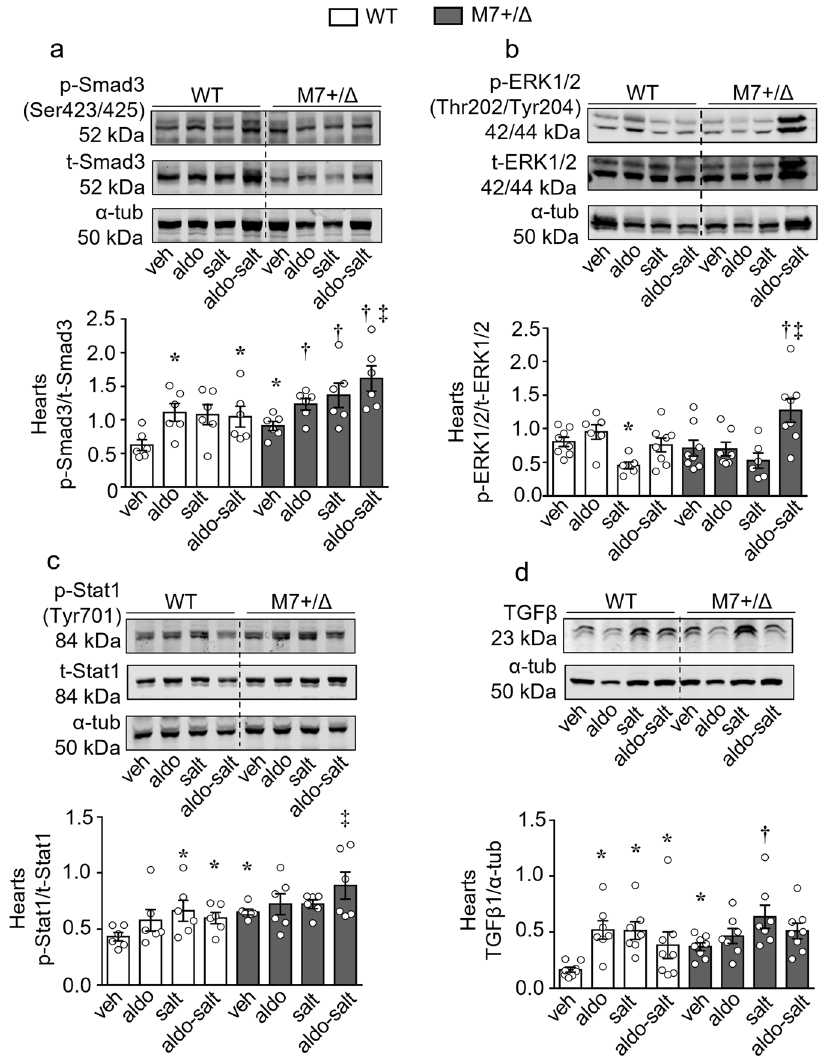
Fig. 6 TRPM7 de fi cient mice exhibit increased activation of Smad3, ERK1/2 and Stat1 and expression TGF β 1. Heart tissues from WT (white bars) and TRPM7 + / Δ kinase (gray bars, M7 + / Δ ) were investigated for the expression of a phospho-Smad3 (Ser423/425), b phospho-ERK1/2 (Thr202/Tyr204), c phospho-Stat1(Tyr701) and d TGF β 1. Protein expression was normalized by total forms of Smad3, ERK1/2, Stat1 or α -tubulin. Data are expressed as mean ± SEM and representative fi gures ( n = 6 – 8/group). One-way ANOVA followed by Dunnett ’ s multiple comparisons test were used for statistical analysis. * P < 0.05 vs WT veh; † p < 0.05 vs M7 + / Δ veh; ‡ p < 0.05 WT aldo-salt vs M7 + / Δ aldo-salt; ‡ p < 0.05 WT aldo-salt vs M7 + /